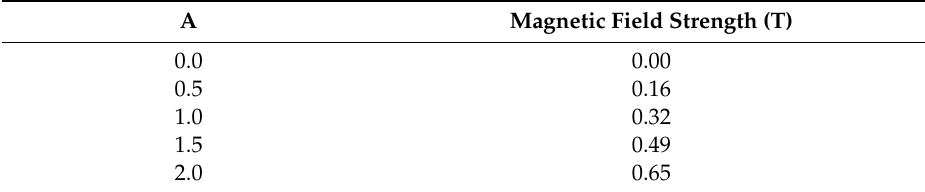
Table 1. Corresponding values between applied currents and magnetic field strength.